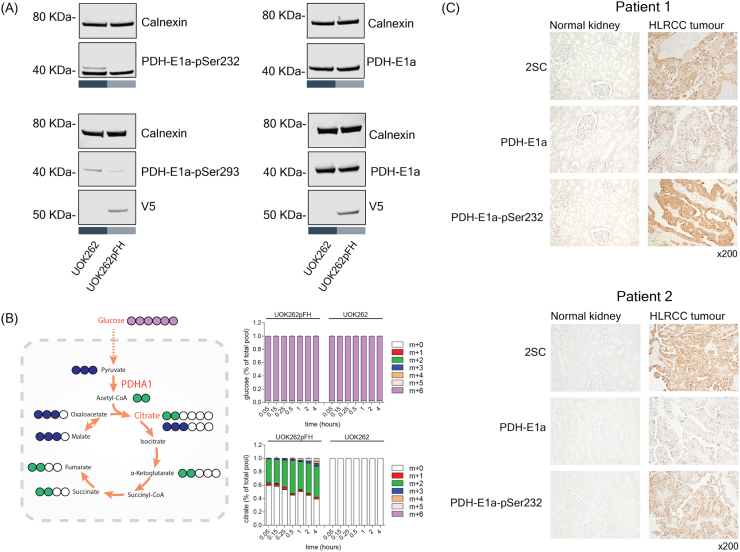
Experimental validation of PDHA1 phosphorylation regulation in FH-deficient cells. A) Western Blot of PDHA1 protein abundance (PDH-E1a) and PDHA1 S232 (PDH-E1a-pSer232) and S293 (PDH-E1a-pSer293) phosphorylation. Calnexin was used as loading control and V5 to stain re-expressed V5-FH-wt in UOK262pFH. B) 13C-Glucose labelling experiment tracking the uptake of glucose into the mitochondria via PDHA1. C) Immunohistochemistry of HLRCC tumours and corresponding adjacent normal kidney tissue stained for PDHA1 and PDHA1 S232 phosphorylation and 2-succinic-cysteine (2SC).